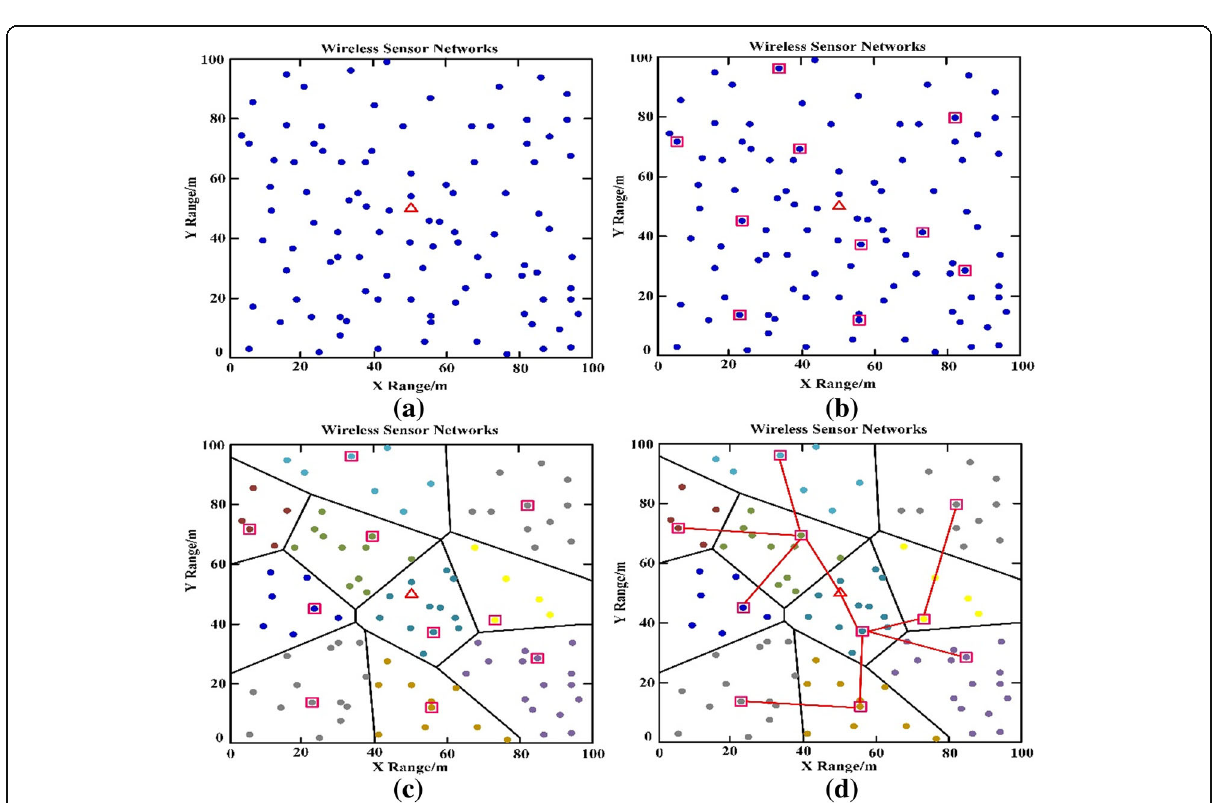
Fig. 4 a shows 100 nodes randomly distributed in the region. ( b ) shows the elected cluster heads. ( c ) shows the clustering. ( d ) shows the optimal